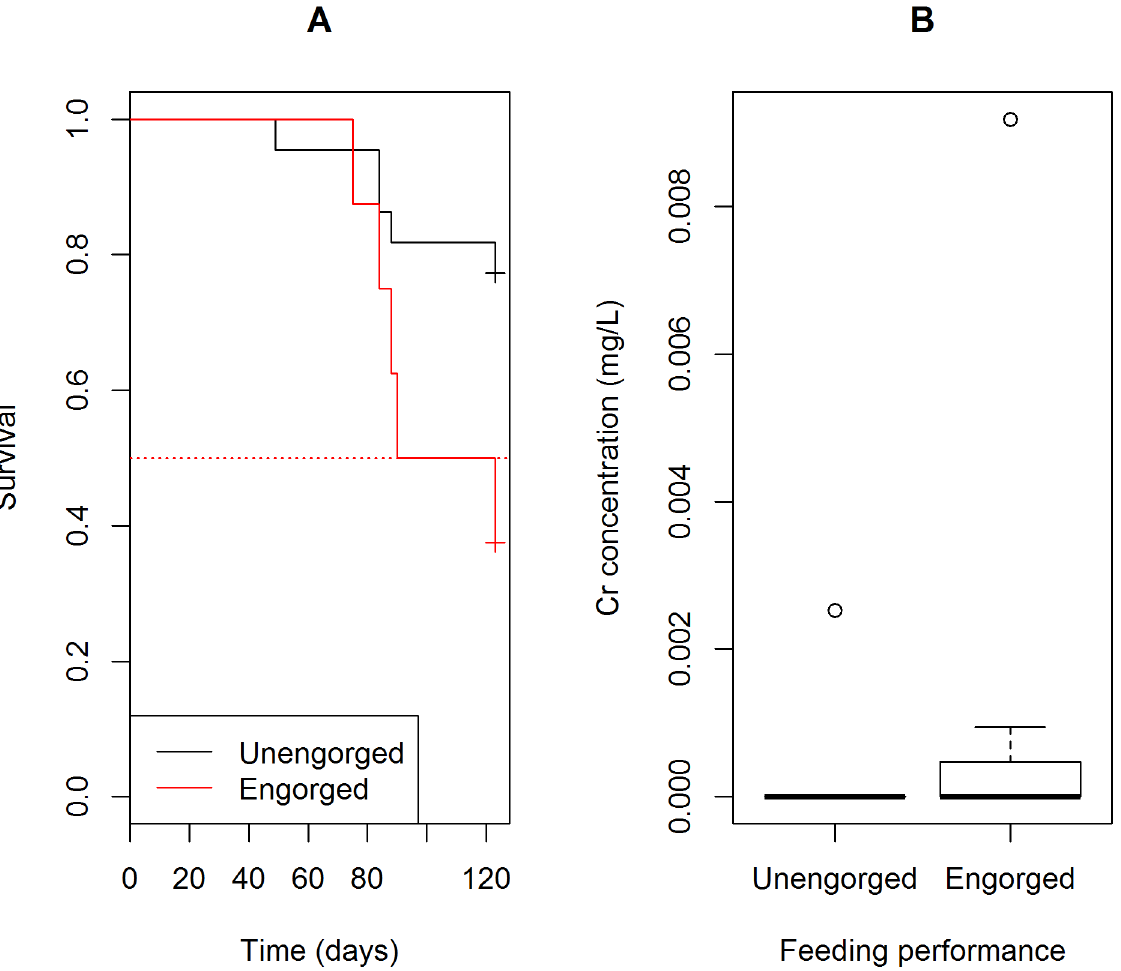
Fig 4. Survival of Cr-marked Triatoma pseudomaculata according to feeding performance (A) and Cr concentration in engorged versus unengorged insects (B)